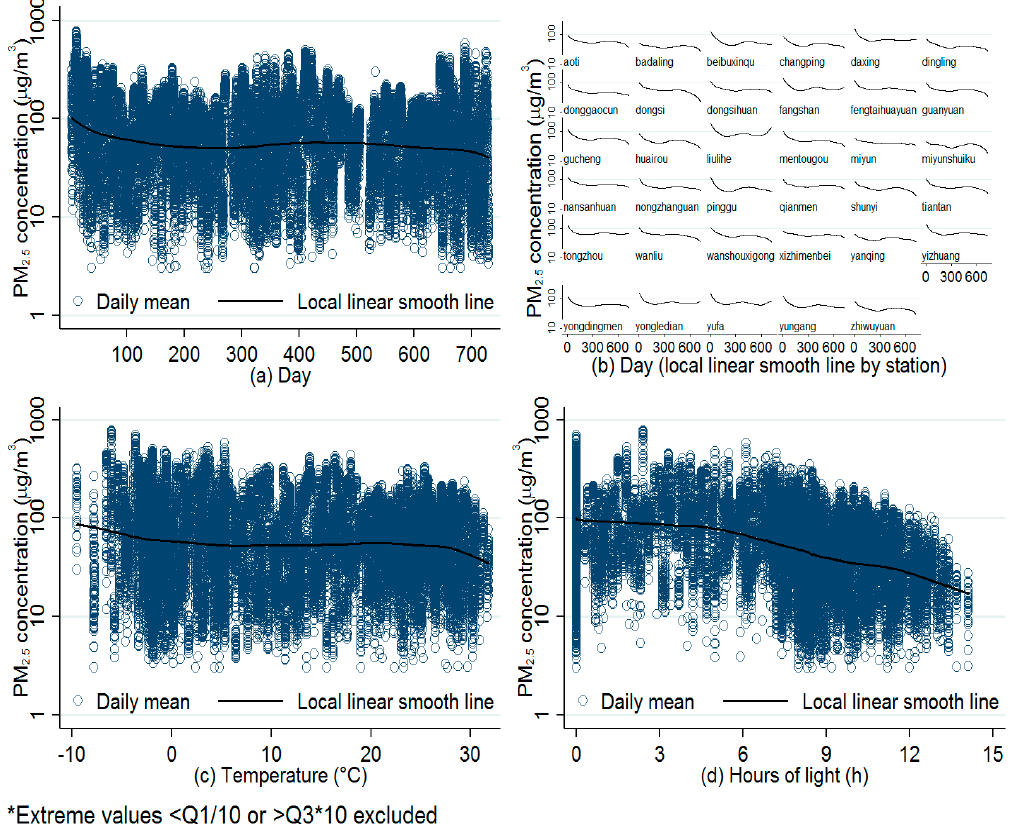
Figure 2. Relationship between daily mean PM 2.5 concentrations and day ( a ) at all stations and ( b ) by stations; relationship between daily mean PM 2.5 concentrations and ( c ) daily mean temperature and ( d ) daily hours of light. Log transformed non-traffic PM 2.5 concentrations at non-background station q , log p NT